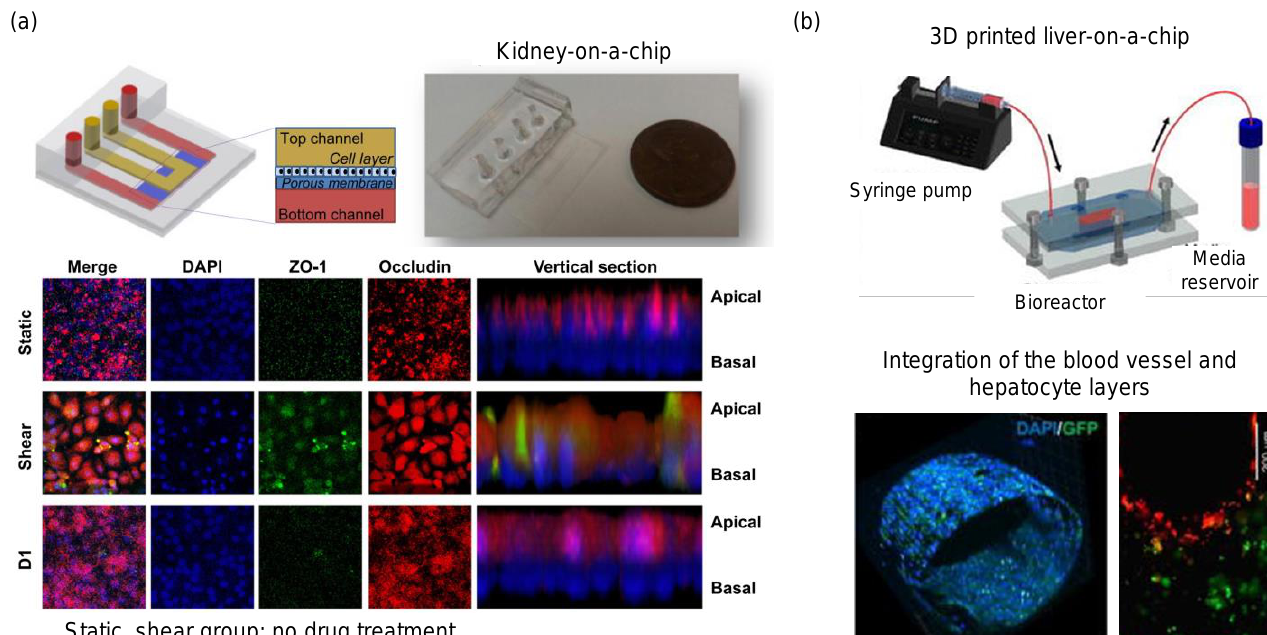
Figure 7. Liver and kidney-on-a-chip for hepatotoxicity and nephrotoxicity testing. ( a ) A study showing a pharmacokinetic profile of reducing nephrotoxicity of gentamicin in perfused kidney on- chip. Figure reproduced from Kim et al., 2016 [79]. ( b ) 3D printed liver-on-chip device for evaluating in-situ hepatocyte cell differentiation. Figure reproduced from Massa et al., 2017 [75].